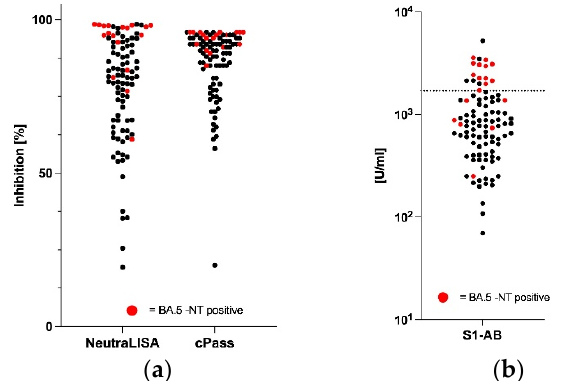
Figure 2. Discrimination of BA.5-NT-positive and -negative sera by quantitative serology. ( a ) Sero- logical neutralization potency determined by inhibition of the binding of the recombinant, biotin- labelled ACE2-receptor to the recombinant SARS-CoV-2-S1/-receptor binding domain (cPass, Genscrip Biotech and NeutraLISA, Euroimmun); ( b ) serum levels of panIg against the SARS-CoV-2 spike (S1) protein receptor binding domain (S1-AB) determined by chemiluminescent immunoassay (ECLIA, Roche Diagnostics). Black dots: BA.5-NT-negative samples; red dots: BA.5-NT-positive samples; dotted line: cut-off at 1700 U/mL.